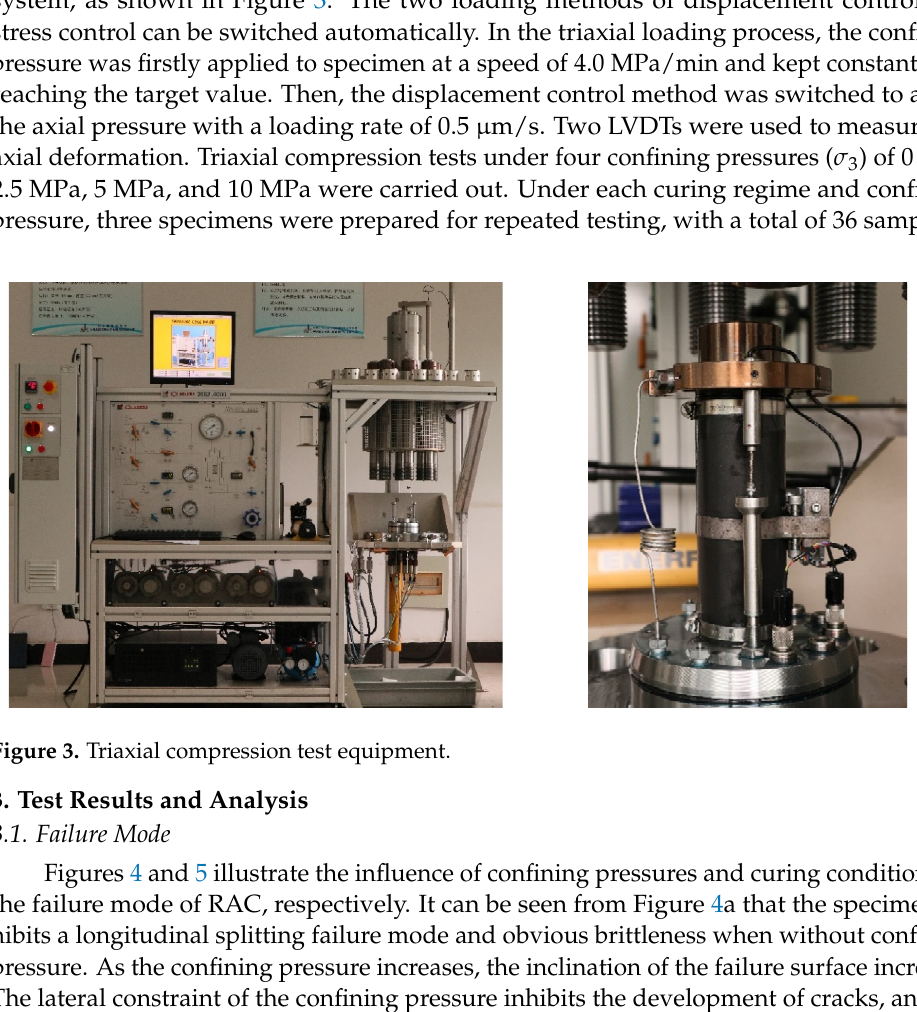
Figure 2. The curves of curing temperature versus time.